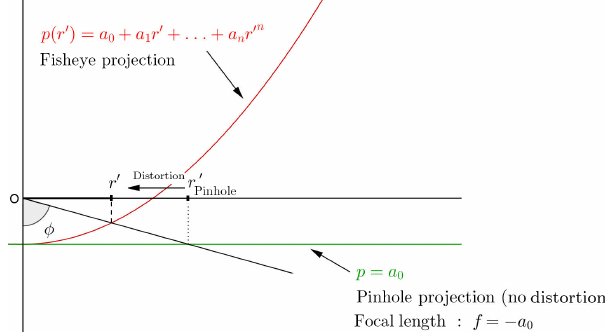
Figure 3. Radial distortion modelization in Scaramuzza et al. (2006) for omnidirectional cameras. Incident angle φ and projected radial distance r (cid:48) are related by tan φ = − r (cid:48) /p(r (cid:48) ) . The polynomial function p is represented by the red curve. The case where there is no distortion (i.e., pinhole projection r (cid:48) = f tan φ ) corresponds to a constant polynomial function p = a 0 represented by the green